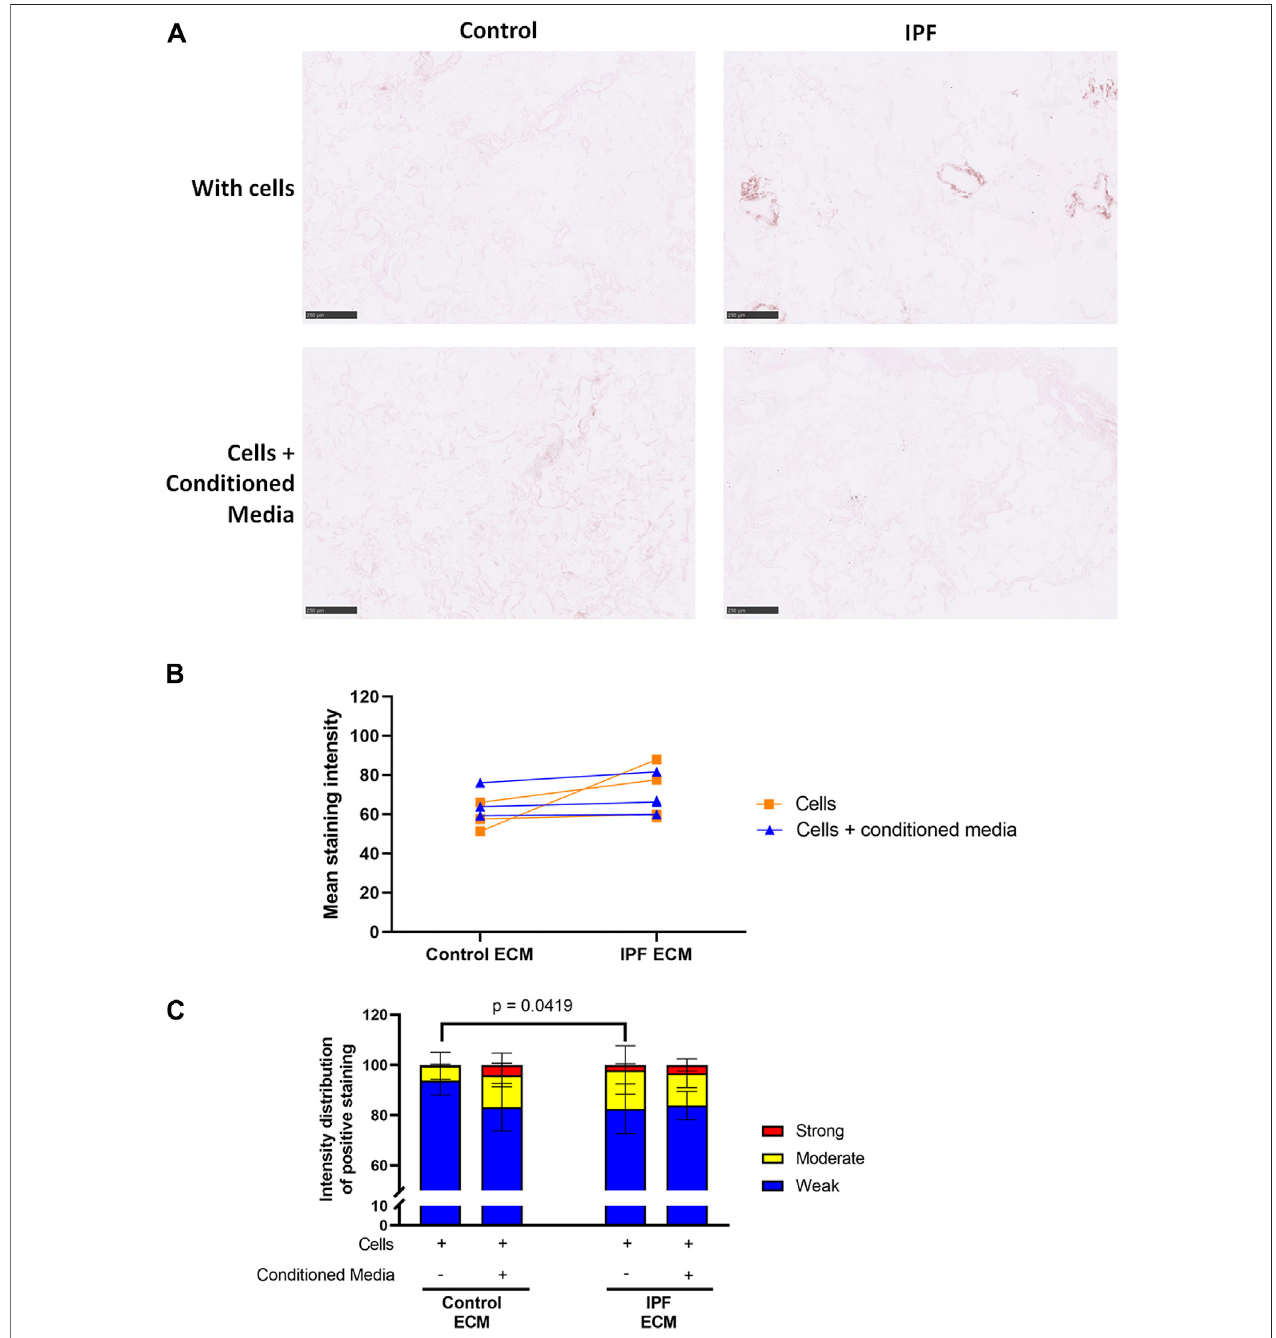
FIGURE6| TreatmentwithASC-CMdoesnotalterthelevelsofdenaturedcollagen.Primarylung fi broblastswereseededintodecellularizedmatricesandcultured in the absence or presence of ASC-CM for 7 days. Sections of recellularized lung tissue were stained using collagen hybridizing peptide (B-CHP, brown) and an eosin counterstain (pink). Data of matrices with cells are repeated from Figure 4 to allow for a clear comparison. (A) Representative images of the stained recellularized matricesshowingamagni fi edpartoftheimageofthetotaltissuesection. Scalebar (cid:2) 250 μ m. (B) Quanti fi cationoftheB-CHPstaining,showingthemeanstaining intensity. (C) Quanti fi cation of the intensity distribution of the B-CHP staining. Groups were compared using a two-way ANOVA followed by the original FDR method of Benjamini and Hochberg as a post-hoc test. p < 0.05 was considered signi fi cant. All matrices are derived from the same control and IPF donor, primary lung fi broblasts were obtained from three different control donors ( n (cid:2) 3, dots connected per n ).